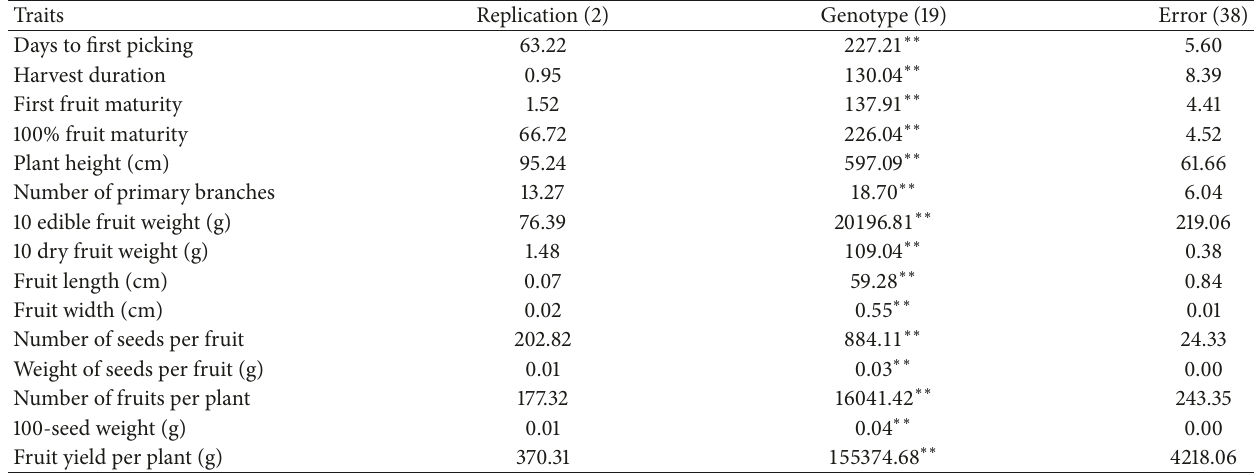
Table 1: Analysis of variance (ANOVA) for 15 characters of